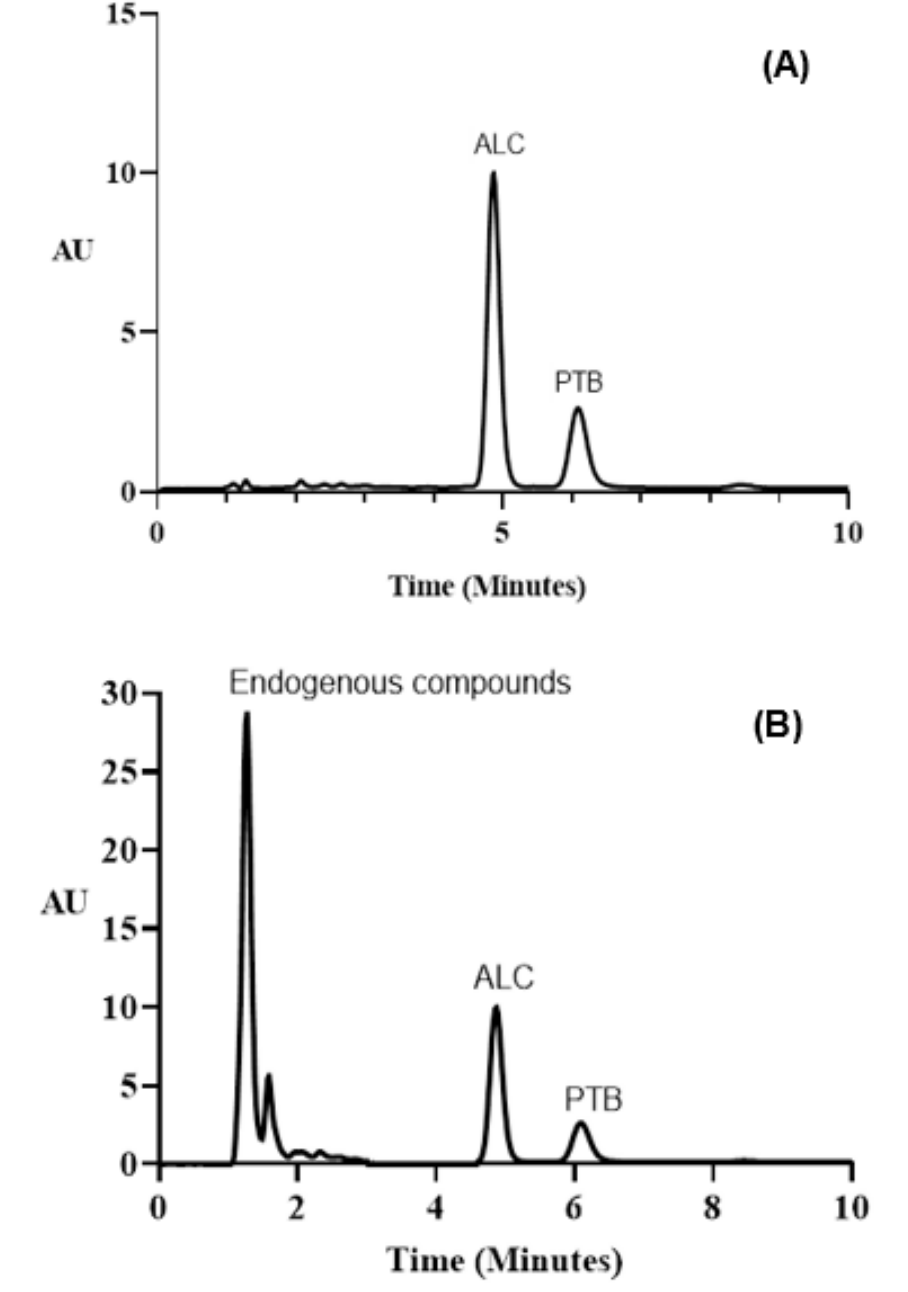
Figure 7. Panel ( A ), a typical chromatogram of ALC (1000 ng mL − 1 ) and PTB (15.6 ng mL − 1 ). Panel ( B ), a typical chromatogram of a urine sample spiked with ALC (1000 ng mL − 1 ) and PTB (15.6 ng mL − 1 ). AU (y-axis) stands for arbitrary units.